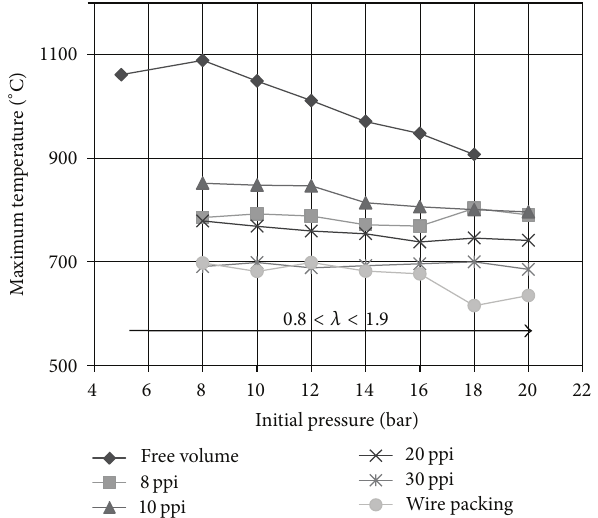
Figure 14: Comparison of maximum combustion temperature for heat release in free volume and in different porous reactors (SiC foam reactors and steel wire packing reactor) as a function of initial for a constant mass of injected fuel (23.7 pressure 𝑝 IB